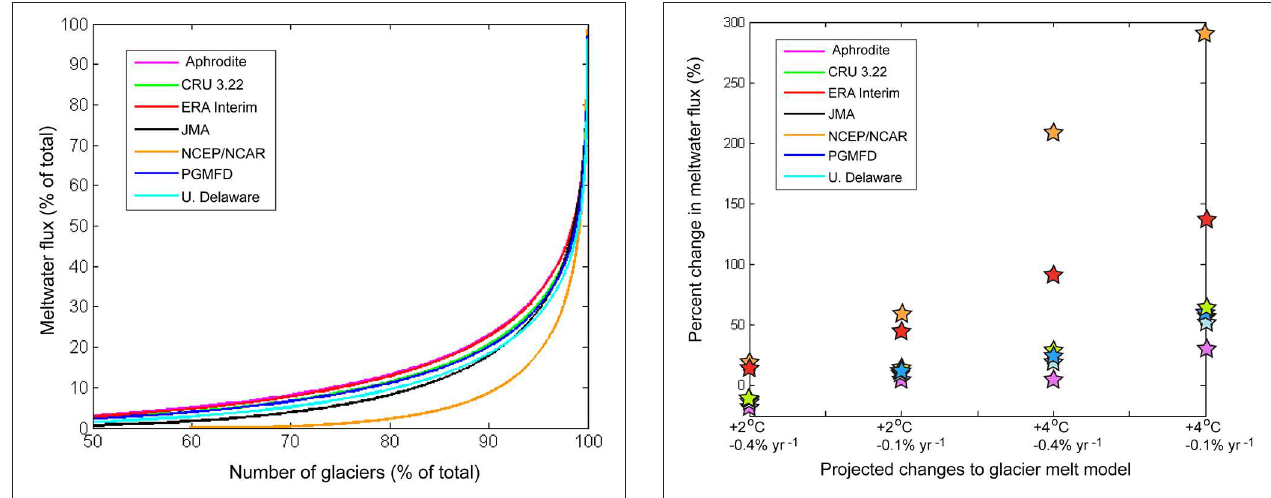
FIGURE 9 | Percentage of glaciers in the Indus watershed contributing to the total glacial melt flux. Regardless of dataset used, less than 1% of the glaciers contribute over 50% of the meltwater, and 10% contribute over 80% of the total meltwater to annual runoff.